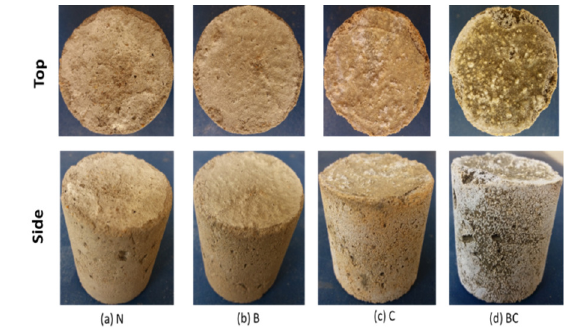
Fig. 7: Magnified Image of Top of BC Sample 3.3 Comparison of N, B, C and BC Samples on 14 th Day of Curing